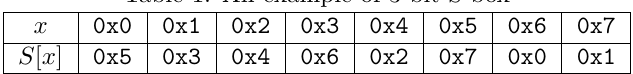
Table 1: An example of 3-bit S-box